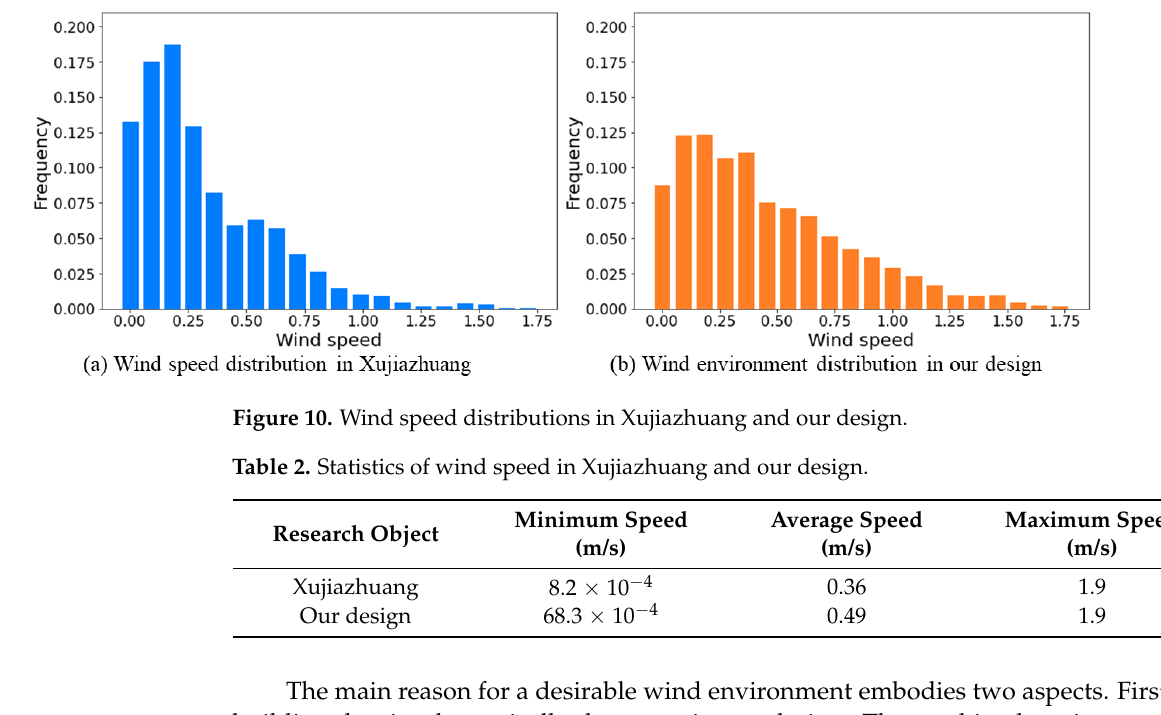
Figure 9. Wind environment simulation by CFD.